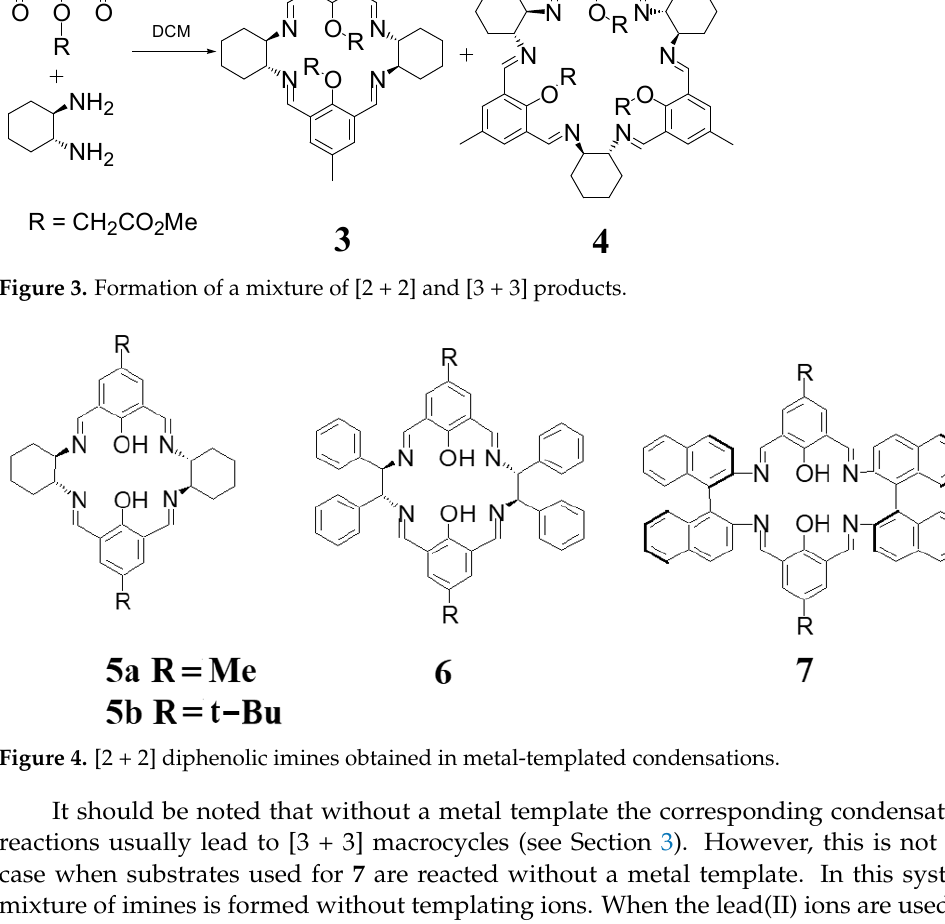
Figure 4. [2 + 2] diphenolic imines obtained in metal-templated condensations.